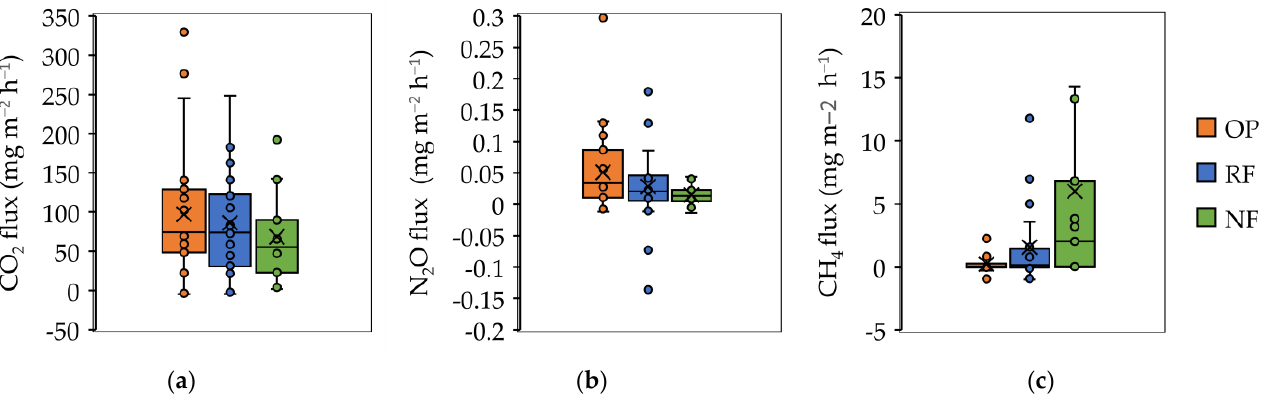
Figure 4. Box and whiskers plot showing 25%, median and 75% quartiles. x is the mean value, 95% confidence interval (whiskers) and outlier emission values at the drained oil palm plantation (OP), rewetting-restored forest (RF) and undrained forest (NF) sites in Raja Musa, Malaysia. ( a ) CO 2 , ( b ) N 2 O and ( c ) CH 4 .